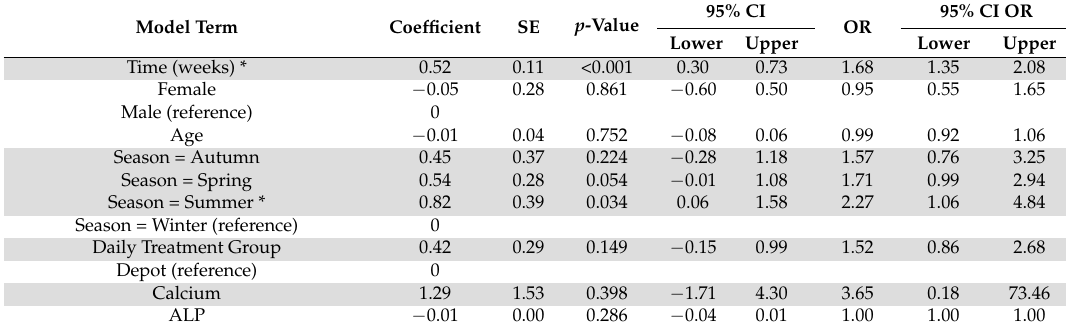
Table 5. GLMM Model 2 Parameter Estimates for meeting Vitamin D serum threshold (25(OH)D > 50